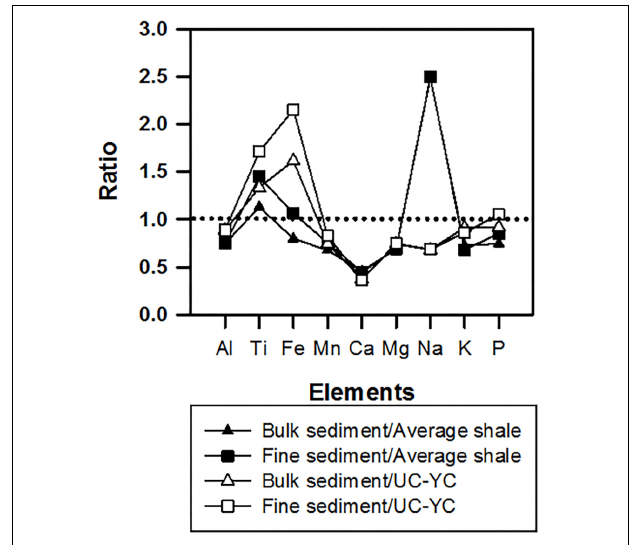
FIGURE 4 | Ratios of concentrations of major elements in surface sediments of the Gulf of Tonkin to those values in upper crust of Yangtze Craton (UC-YC) and average